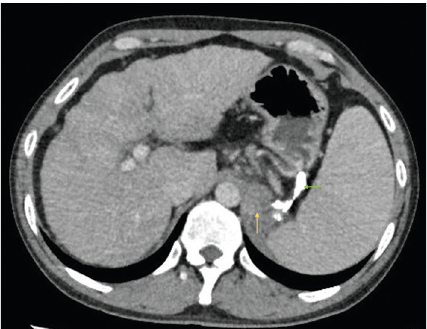
Figure 6: Computed tomography view of the abdomen (in axial view) after completion of antibiotics. The previously seen retro- gastric abscess has completely resolved leaving behind a small area of scarred tissue (yellow arrow). The residual N-butyl-2-cyano- acrylate in the perigastric region is still visible (green